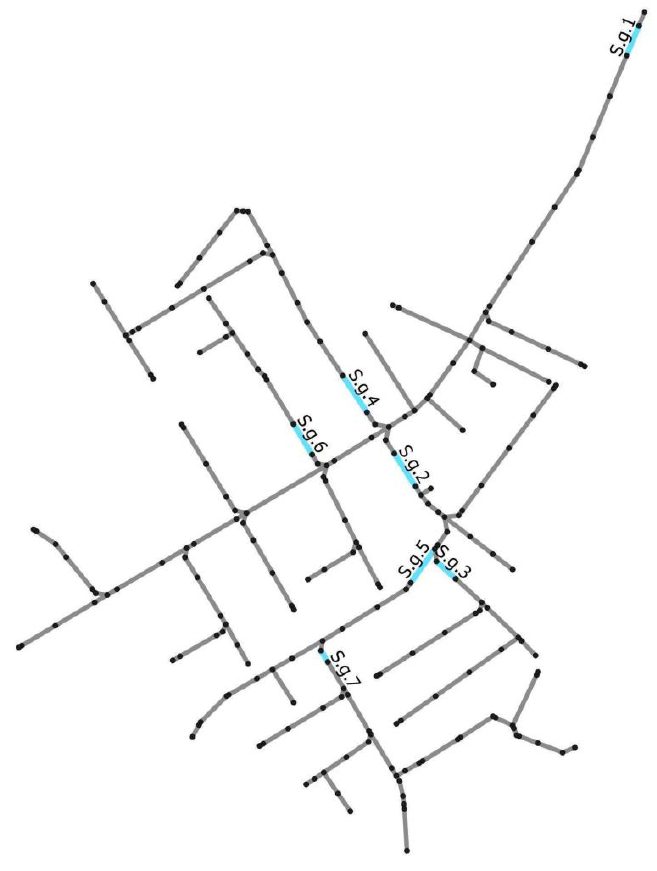
Figure 7. Network scheme with sluice gate positioning. Table 2. Characteristics of the sub-basins controlled by each sluice gate.